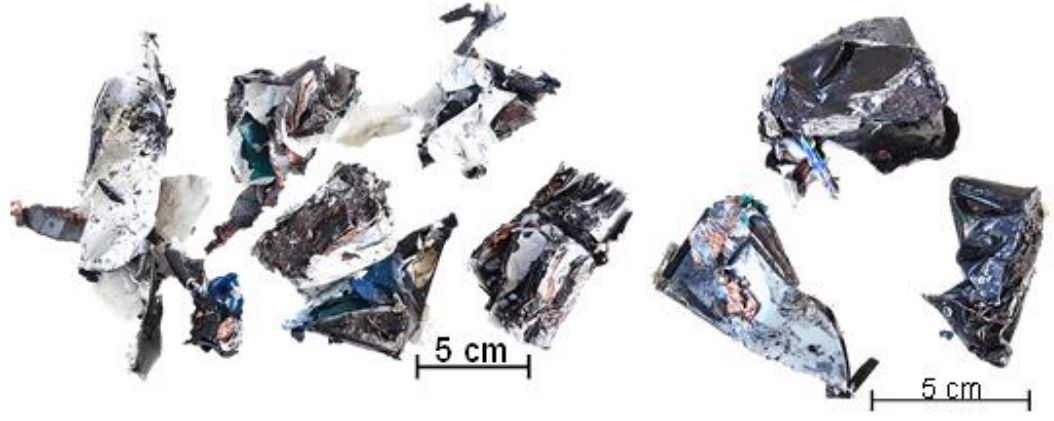
Figure 2. Pre-shredded battery cell type 1 ( left ) and type 2 ( right ).